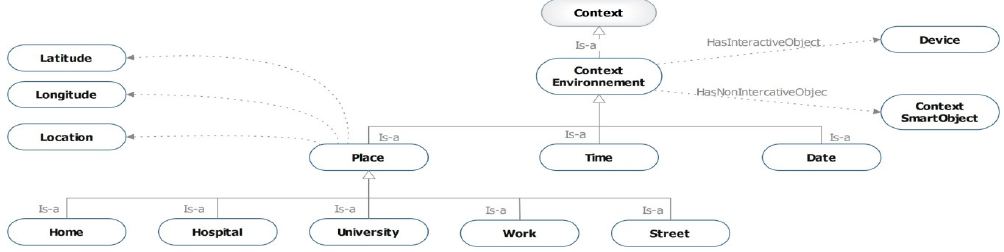
Figure 8. Environment context sub ‐ ontology.